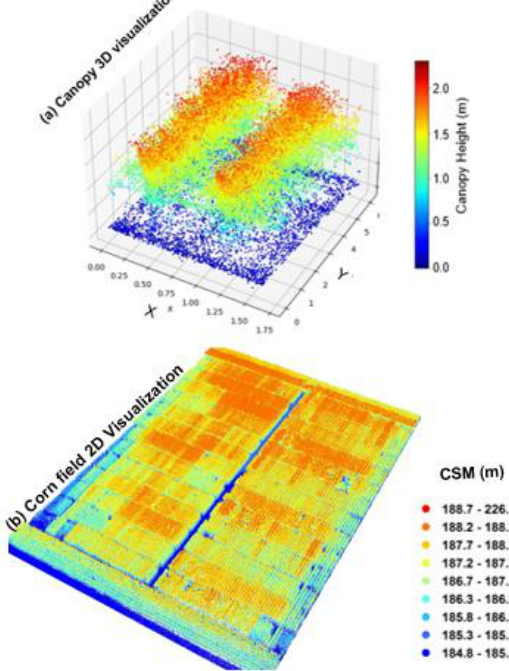
Figure 2. LiDAR Point Cloud Visualization of the maize field.